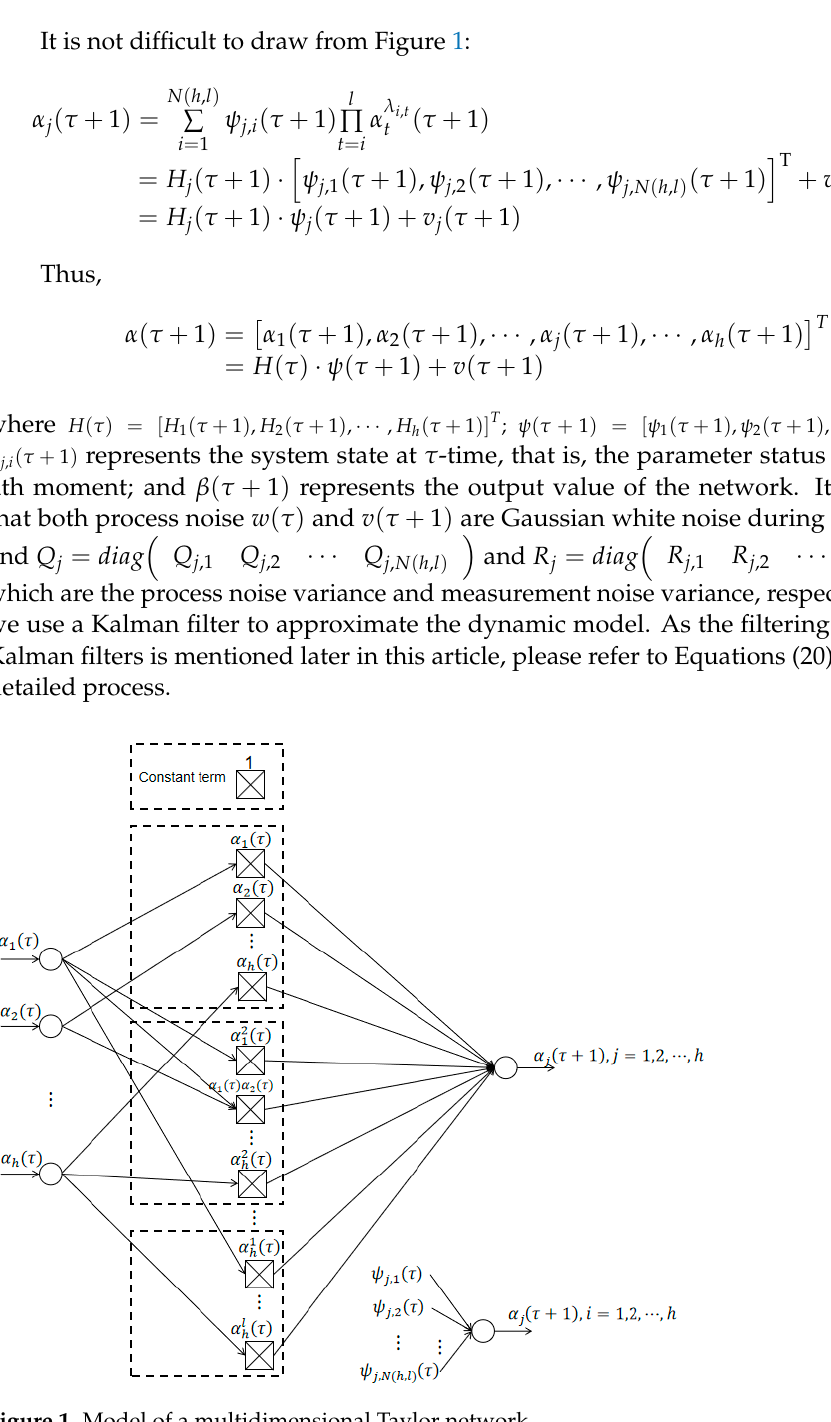
Figure 1. Model of a multidimensional Taylor network.